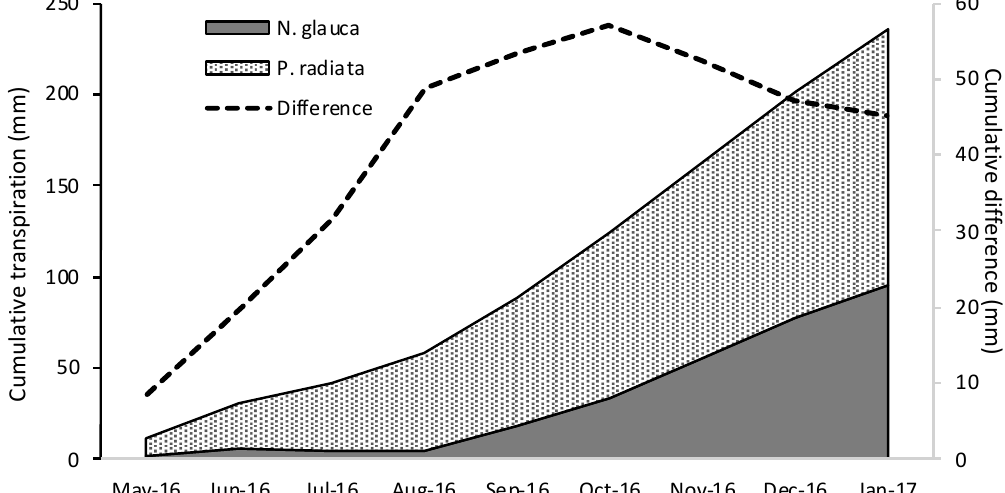
Figure 6. Cumulative transpiration on a ground area basis of both P. radiata and N. glauca in a mixed stand in central Chile. The cumulative difference between the P. radiata and N. glauca is also shown.